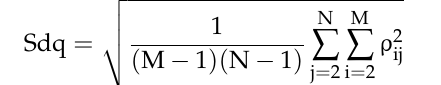
Figure 4. Successfully formed specimen: ( a ) inner side ( b ) outer side.